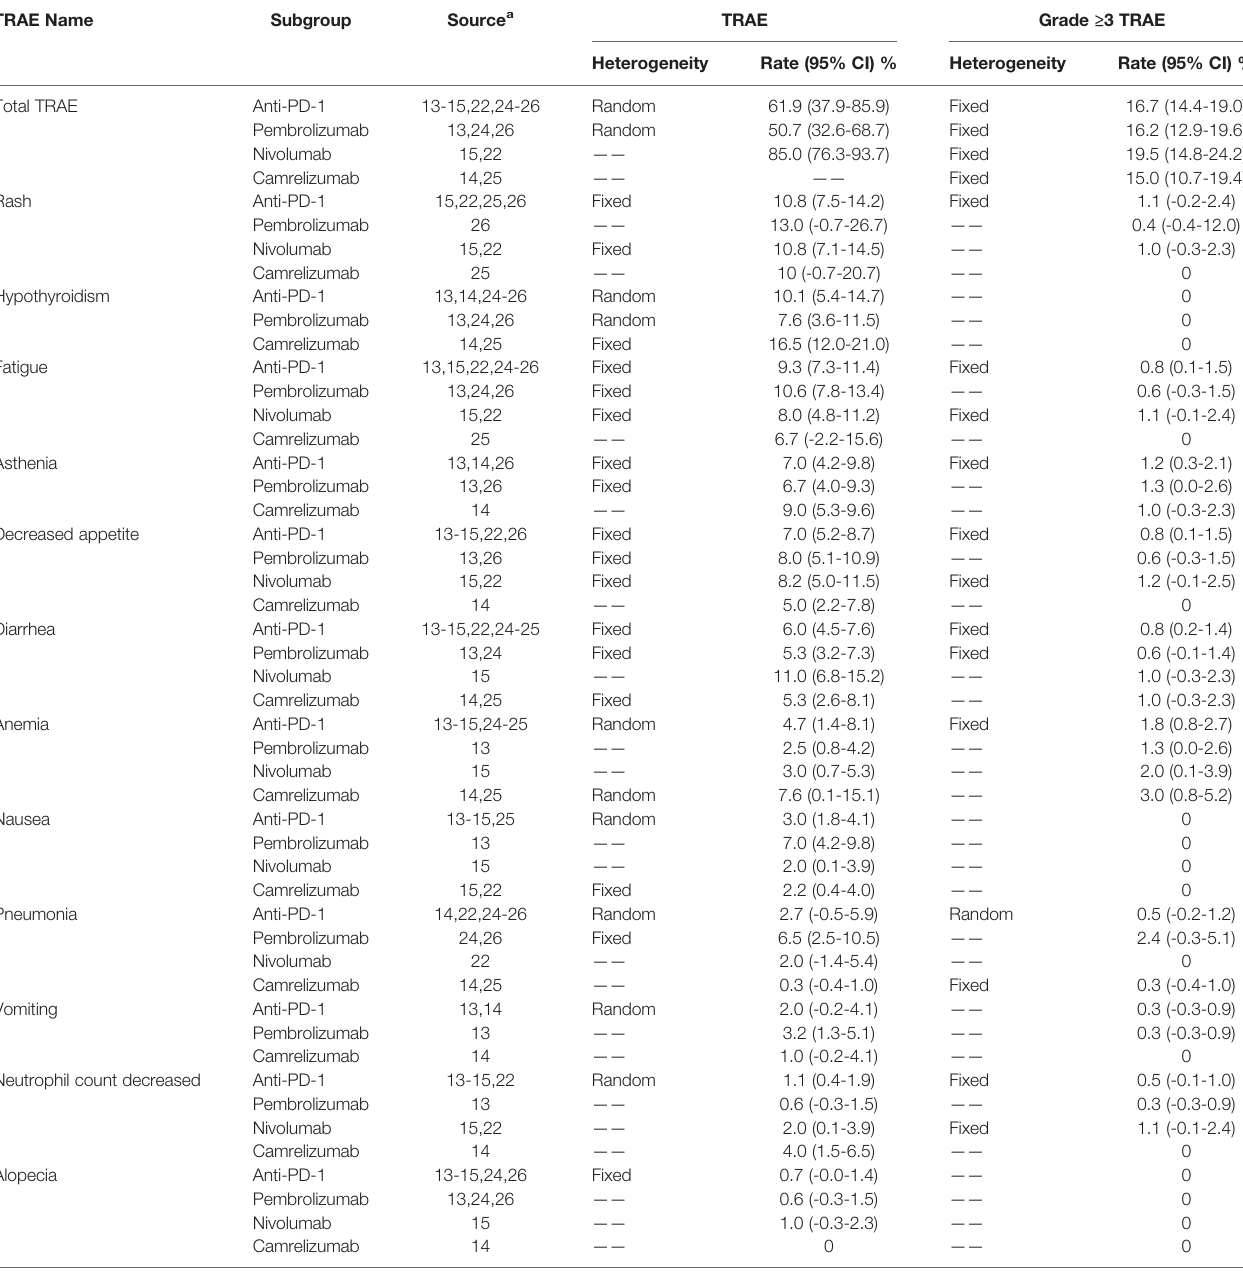
TABLE 3 | The incidence of speci fi c TRAEs, grade ≥ 3 TRAEs. TRAE